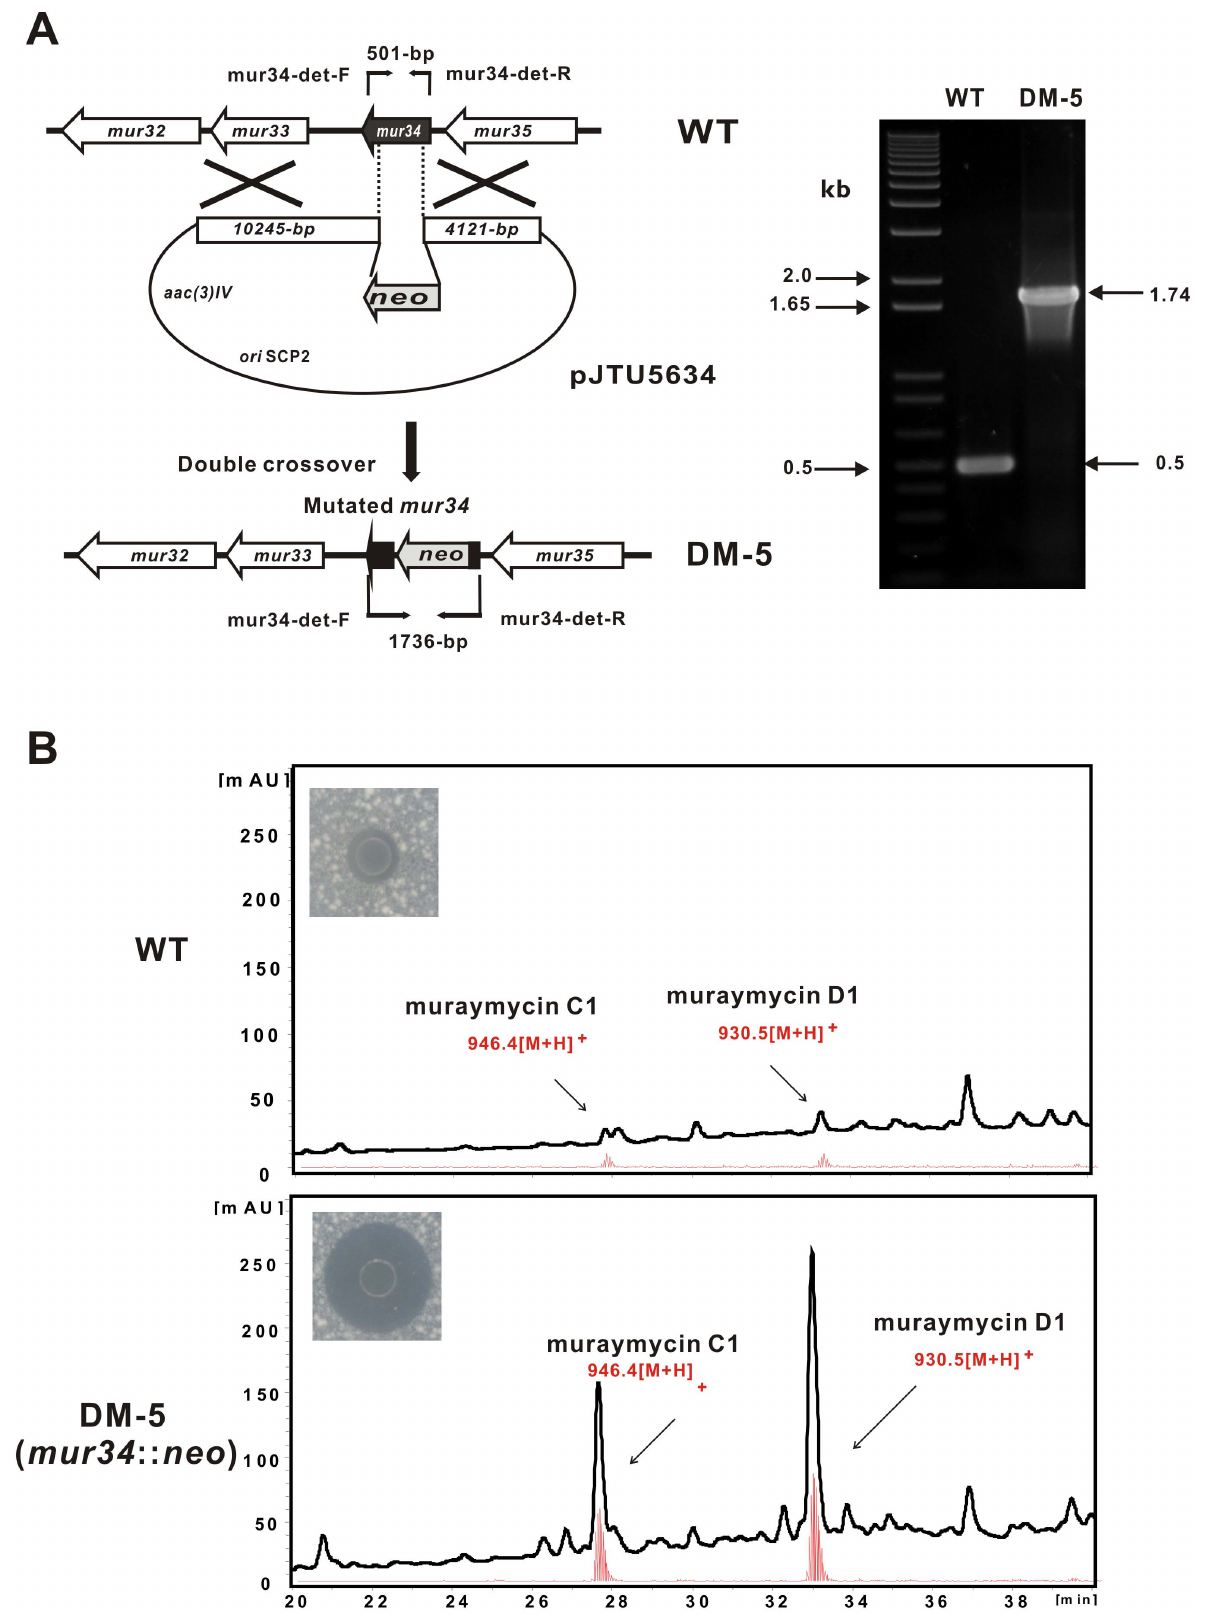
Figure 2. Mutational analysis of mur34 . (A) Schematic representation for the construction of DM-5 mutant, as a 0.23-kb of mur34 was replaced by the 1.43-kb neo cassette, the DM-5 mutant gives a 1.74-kb PCR product, while the wild type strain is 0.5-kb. (B) Bioassay and LC-MS analysis of the